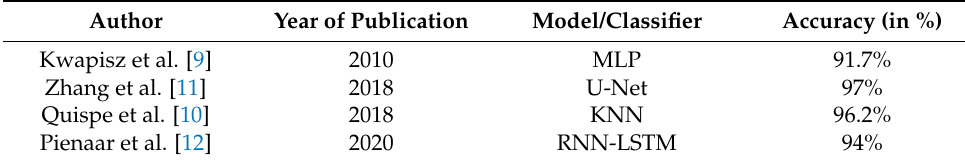
Table 1. Performance measurement of some latest HAR approaches on the WISDM